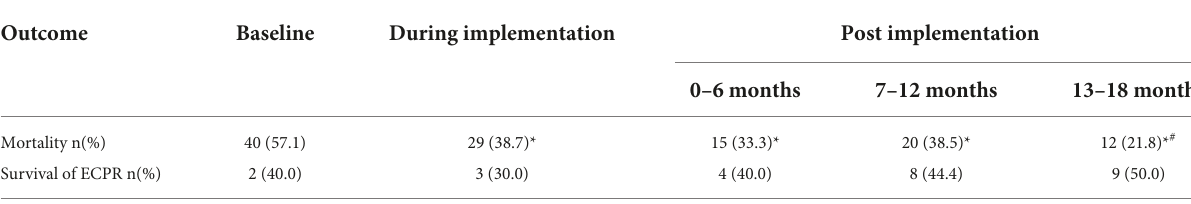
TABLE 4 Mortality of all extracorporeal membrane oxygenation (ECMO) patients and survival of extracorpareal cardiopulmonary resuscitation (ECPR) from baseline to 18 months of follow-up. Outcome